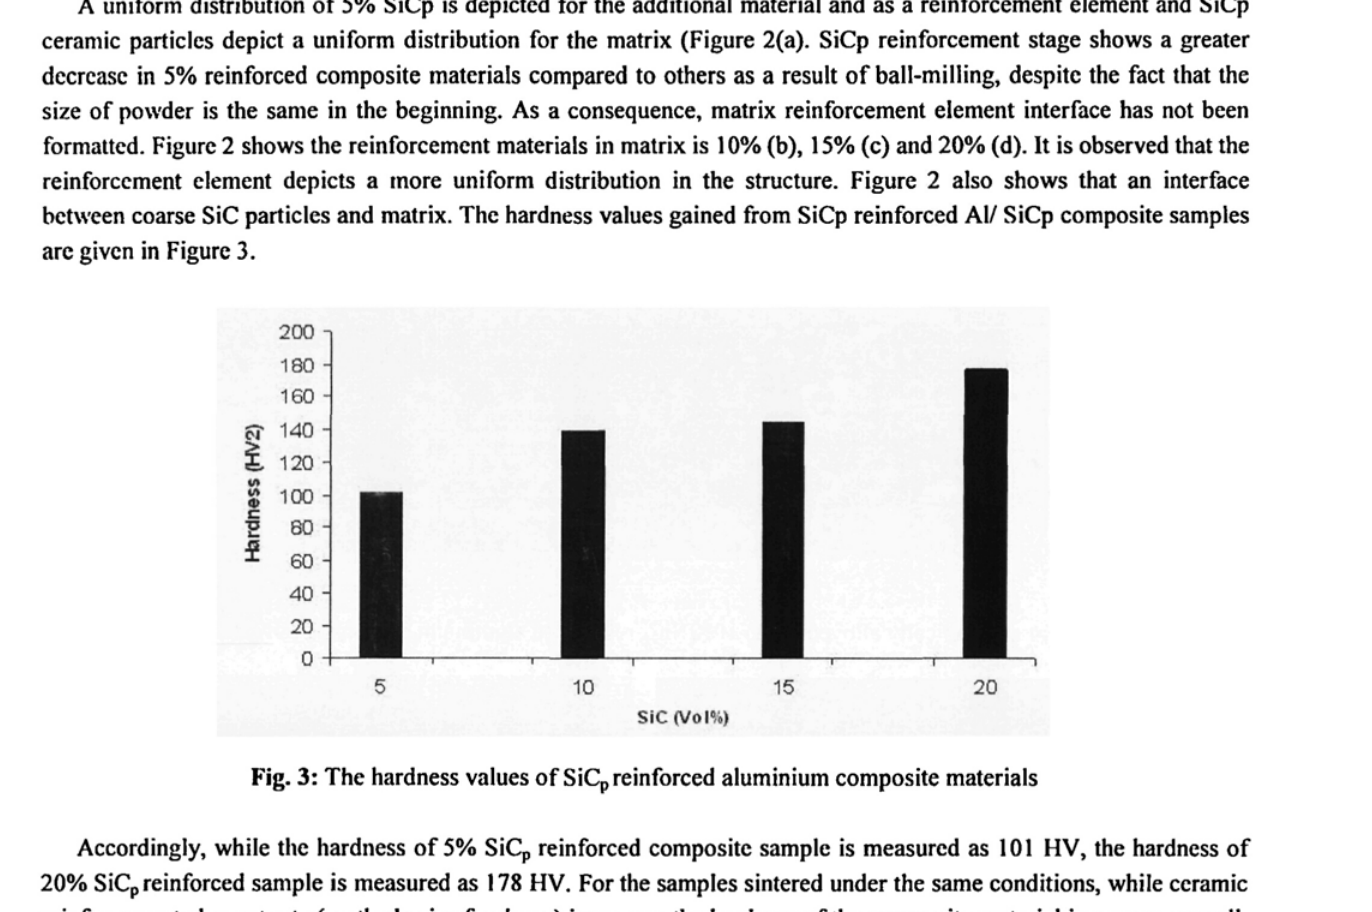
reinforced aluminium composite p